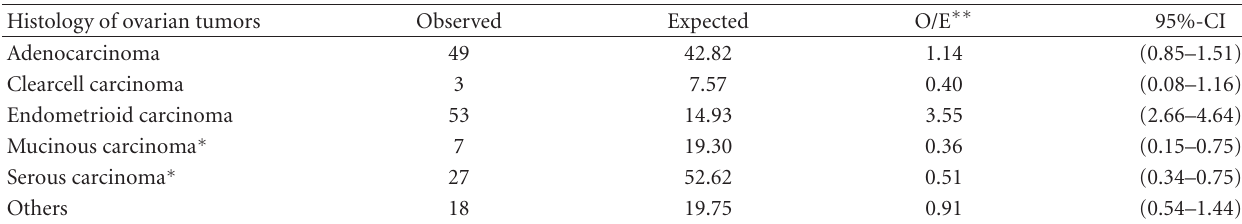
Table 2: Association among 157 cases between subtype of epithelial ovarian cancer and second endometrial cancer. Histology of ovarian